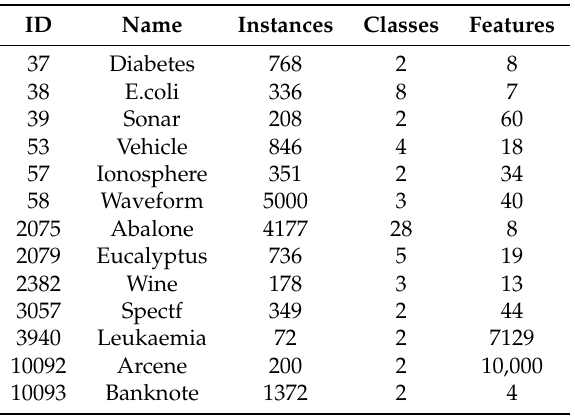
Table 4. Description of test datasets used for evaluation of feature